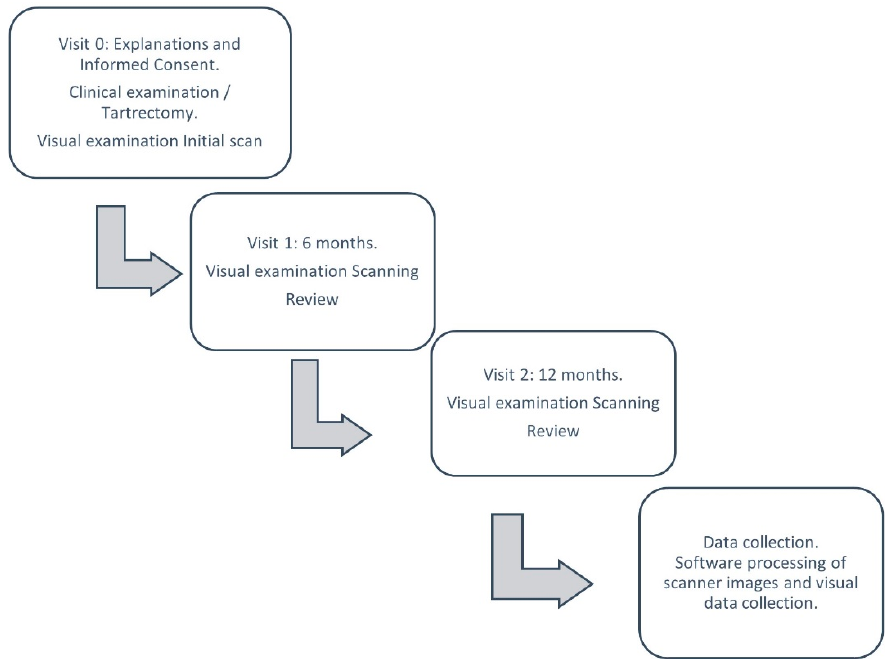
Figure 1. Flow chart of data collection.